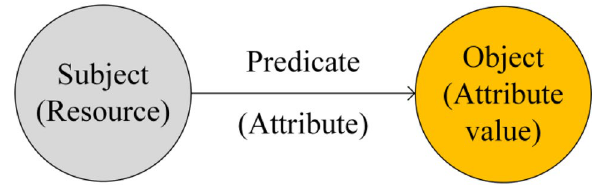
Figure 3. The three-tuple.